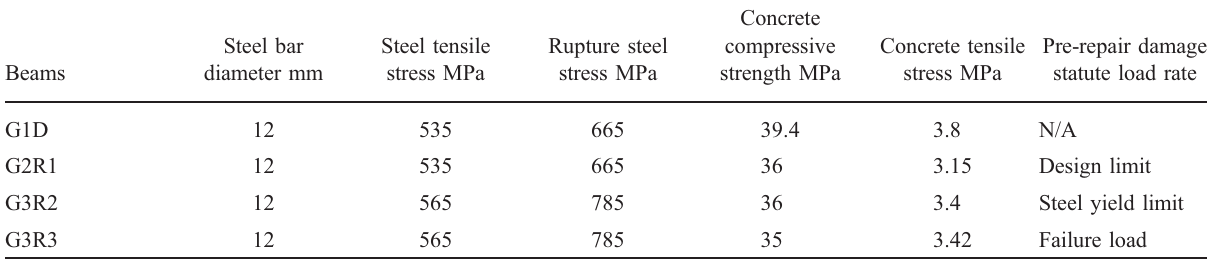
Table 1. RC beam properties